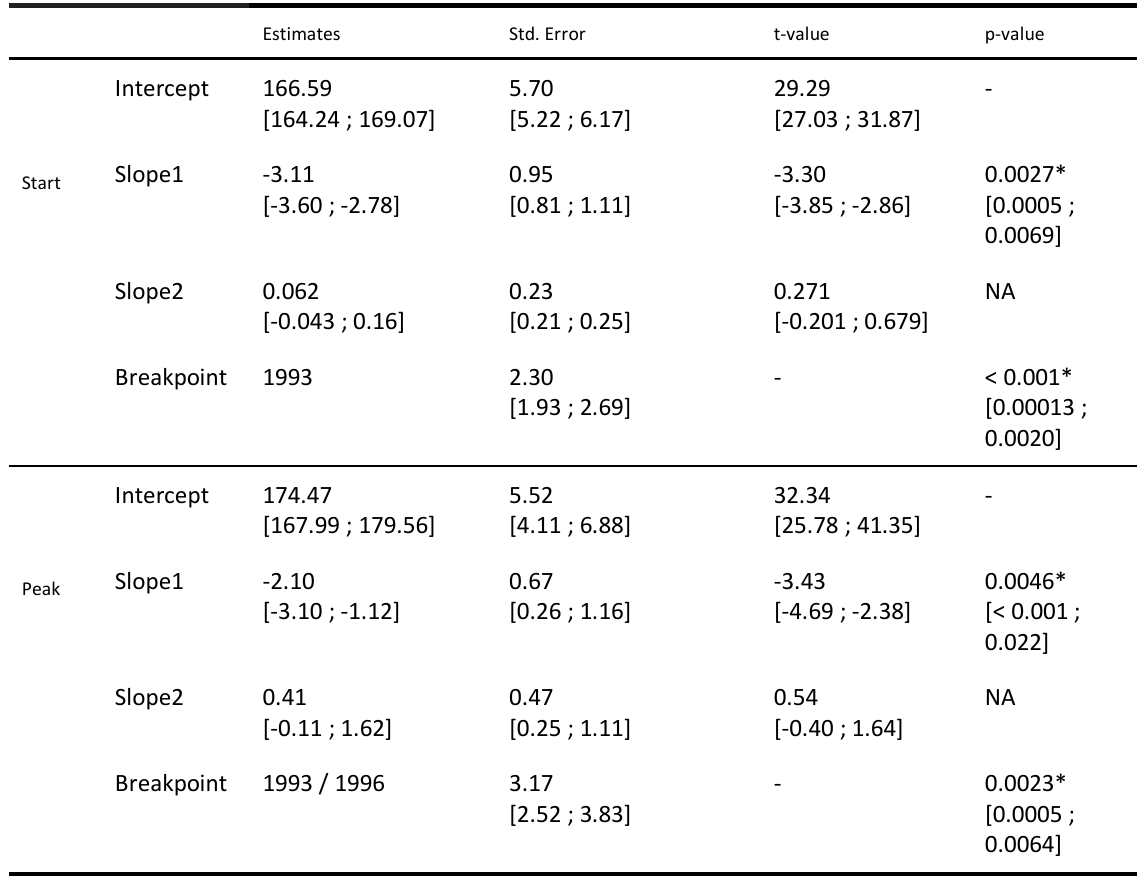
Table S1. Summary of the simulated piecewise regressions on the start and peak of the breeding season. For both intercept and slopes we show the estimate, its standard error, and the t-value and p-value associated with it. Moreover, for each parameter we show in square brackets the 2.5 th and the 97.5 th percentiles of the values obtained by running 1000 models. Slope1 refers to the segment before the breakpoint and Slope2 refers to the segment after the breakpoint. Asterisks next to the p-values show significance at the 0.05 level. The p-value for Slope2 is NA since standard asymptotics do not apply (Muggeo, 2008). No p-values are provided for the intercept because this test is not of biological